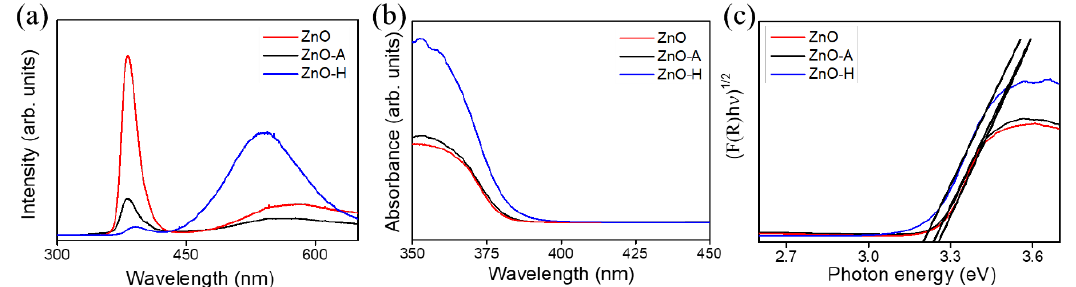
Figure 6. ( a ) The photoluminescence (PL) spectra of various ZnO sheets. ( b ) UV–vis diffuse reflectance spectra of various ZnO sheets. ( c ) Bandgap energies of various ZnO sheets.